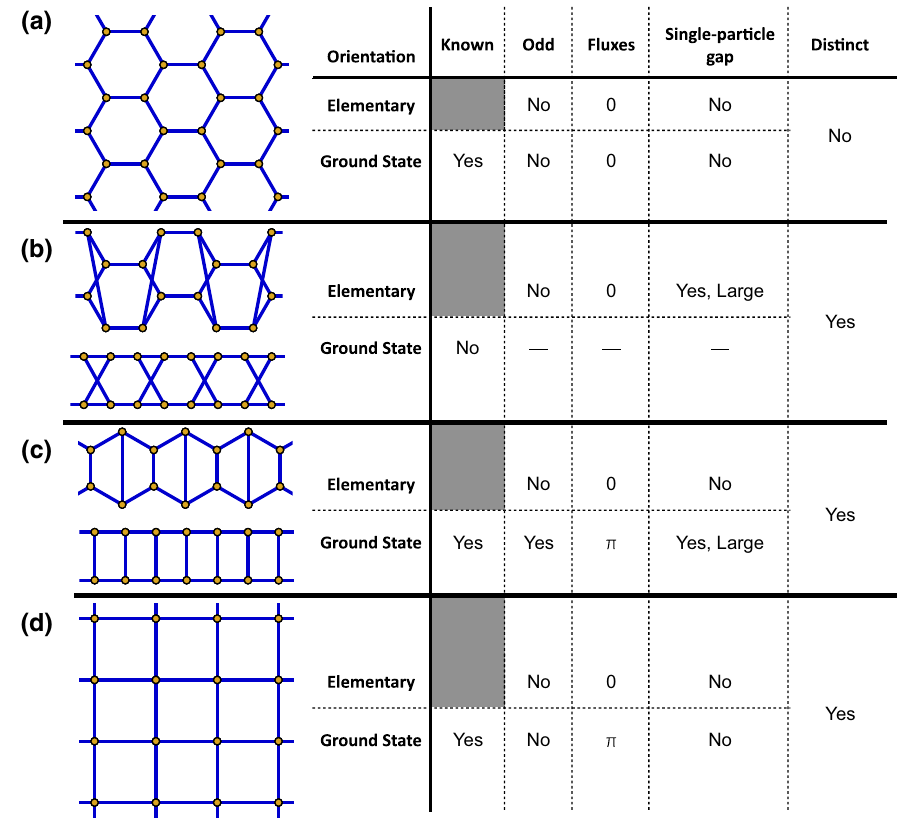
FIG. 7. Table of known properties for the four main examples in Fig. 6: (a) graphene, (b) the n = 2, m = 0 carbon nanotube, (c) the n = 1, m = 1 carbon nanotube, and (d) the square lattice. For each graph, the cycle-orientation, plaquette fluxes, and single-particle gap are tabulated for two key orientations: the elementary orientation and the ground state (if known). In the case of graphene, these two orientations are the same, whereas in the three others they are distinct. Both nanotubes have simpler realizations as a ladder or hourglass ladder, and both equivalent versions of the graph are shown. The two orientations of (b),(c) and the accompanying densities of states are shown in Figs. 8 and 9, respectively. Each example embodies the trends shown in Fig. 6 for creation of single-particle gaps, with the quasi-one-dimensional and 3-coordinated nanotubes exhibiting the largest single-particle